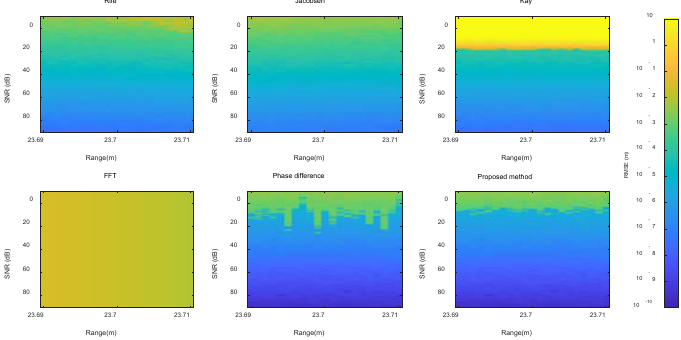
Fig. 3. RMSE comparison of different